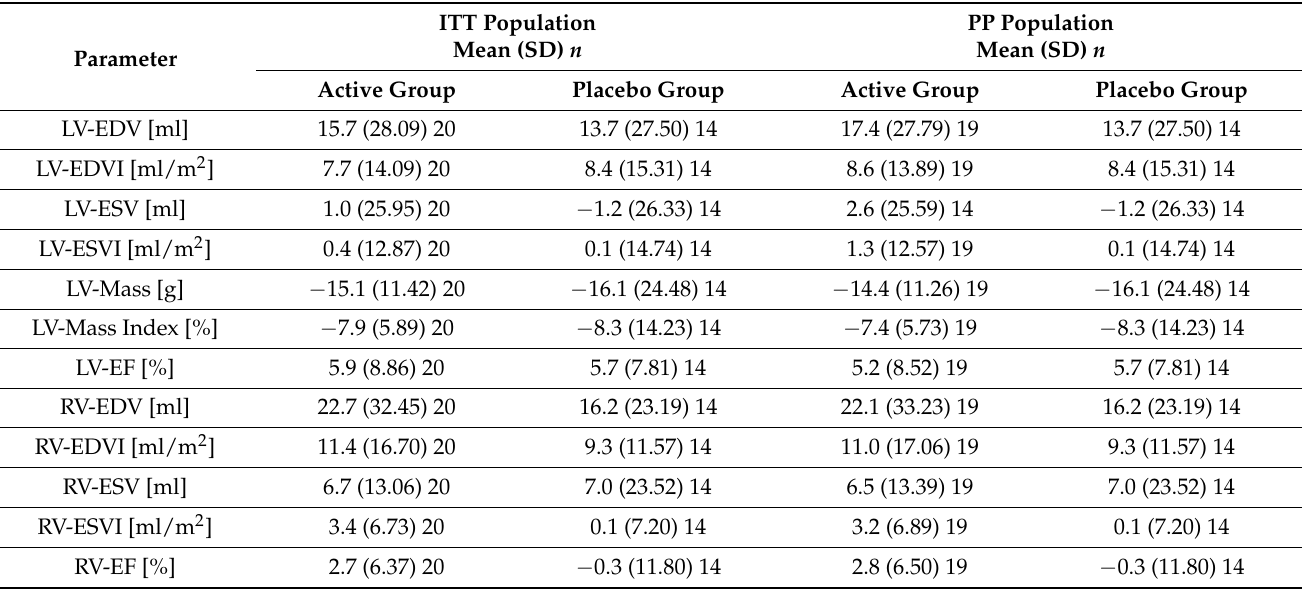
Table 4. Summary of Mean Cardiac Magnetic Resonance Imaging Results for Left and Right Ventric- ular Parameters: Change from Day 3 to Day 90 (ITT and PP Populations).